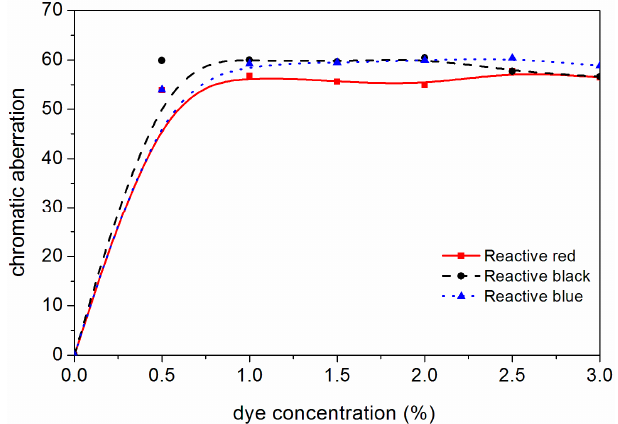
Figure 3. Effect of reactive brilliant red X-3B dye, reactive black KN-B dye and reactive blue K-3R dye concentrations on chromatic aberration.